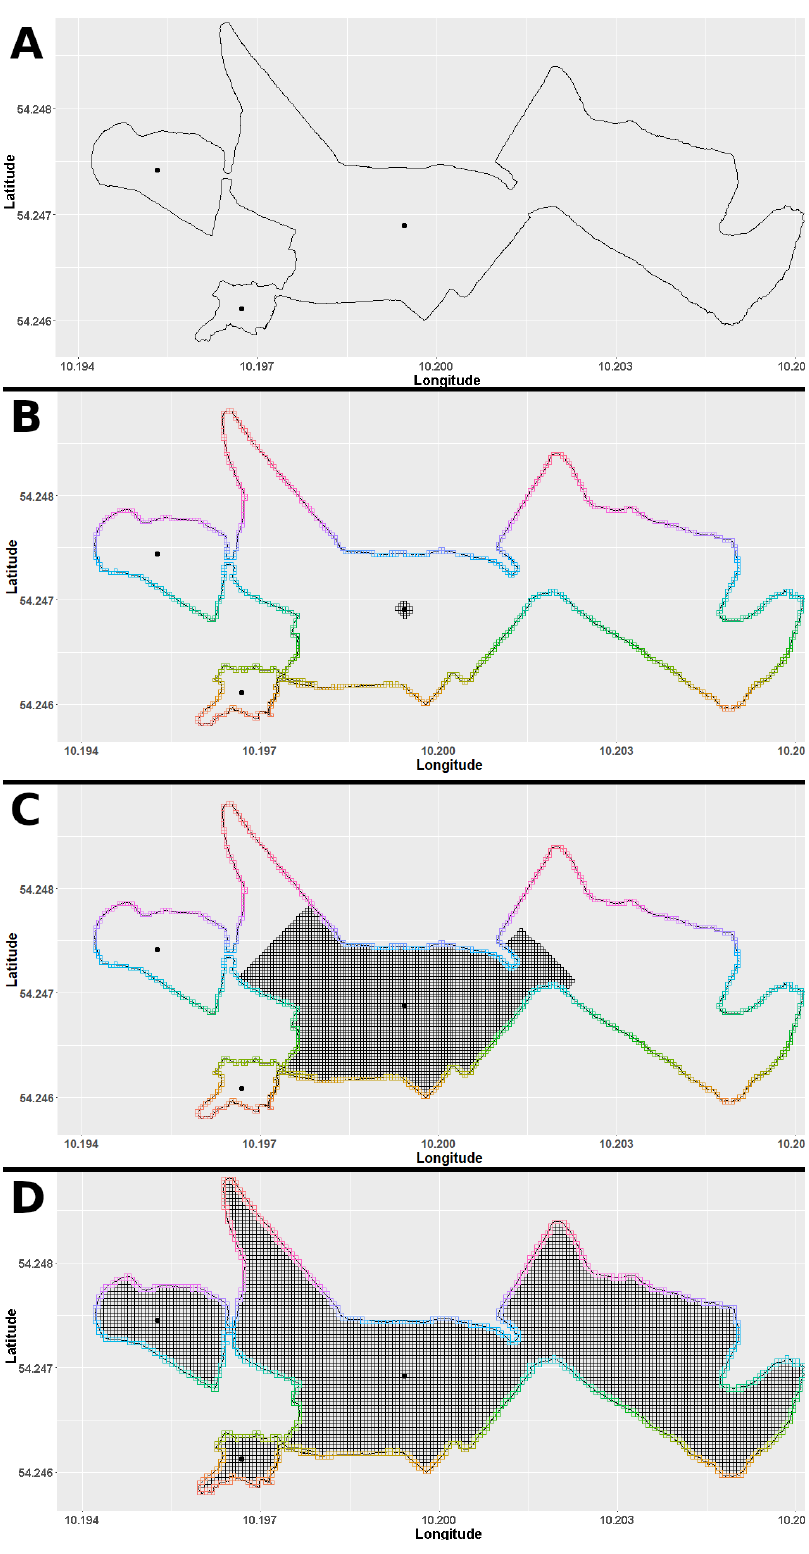
Figure 2. ( A ) Boundary of the area of observation. Black dots mark inner points. ( B ) Starting from an inner point, neighboring squares are added. ( C ) Filling up the area of observation has stopped on the constriction on the bottom left, because it is narrower than the side length. The remaining sectors will be filled starting with the next given inner point. ( D ) Full area gridded with squares of side length 5